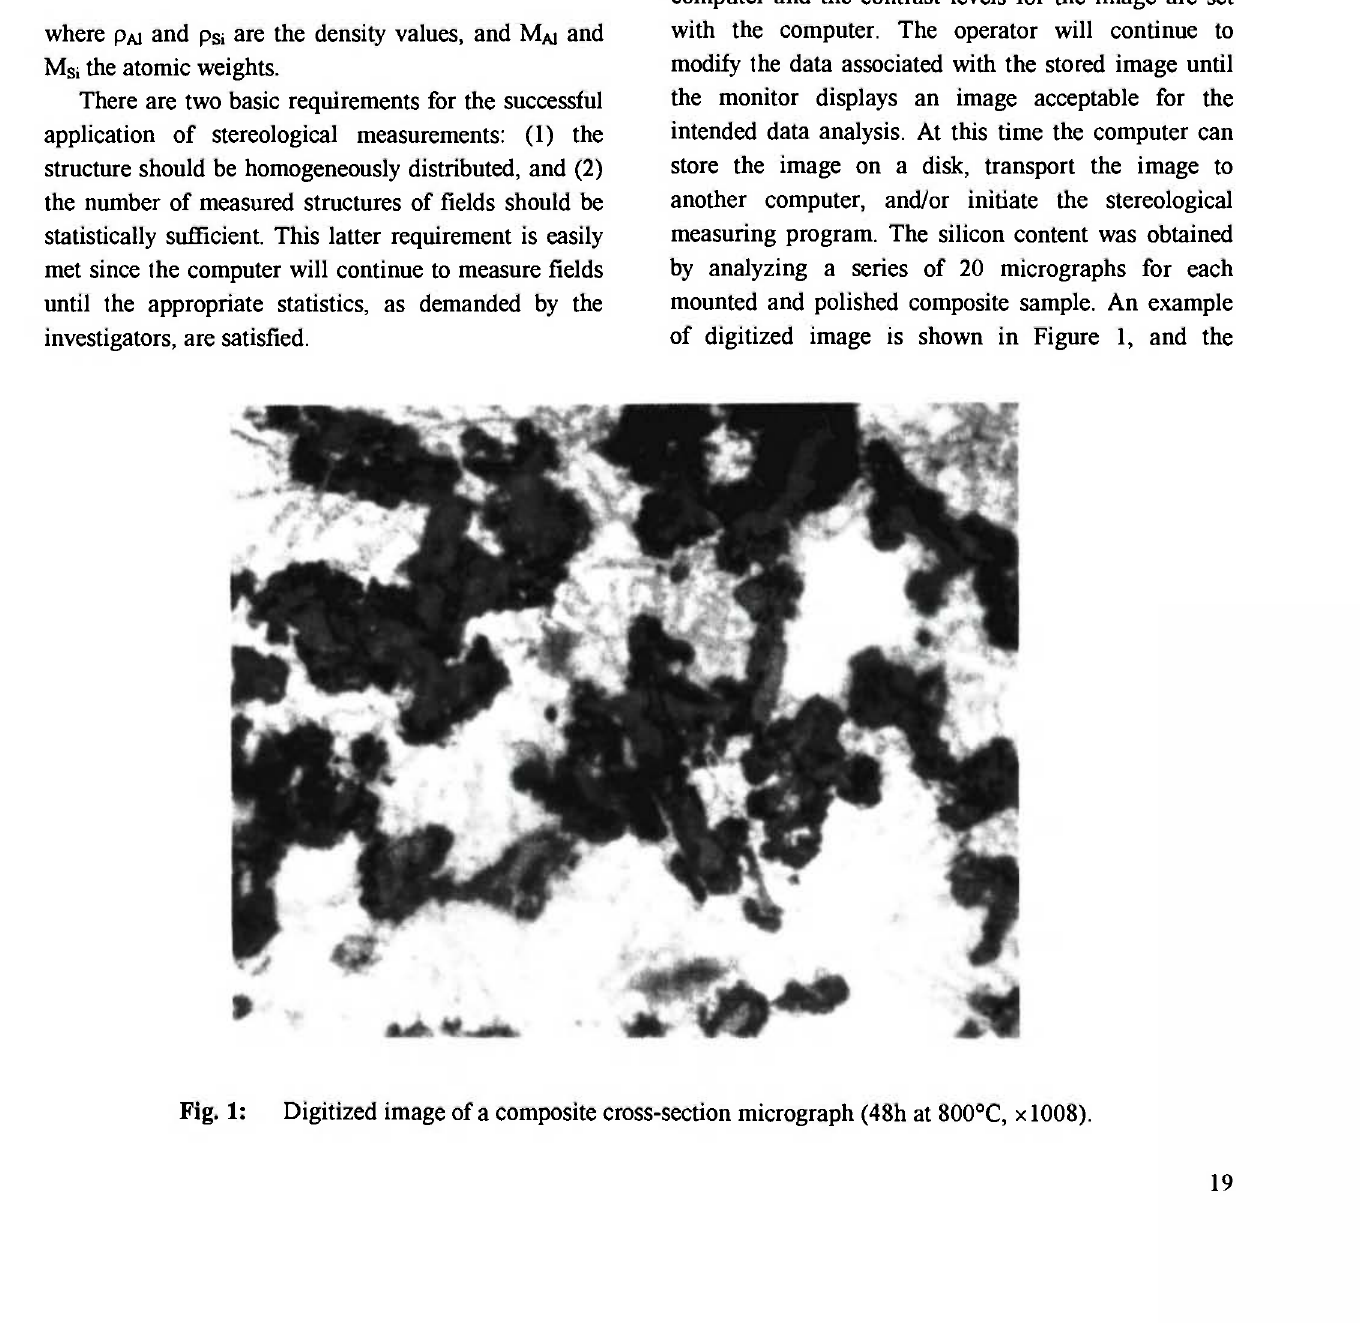
Fig. 1: Digitized image of a composite cross-section micrograph (48h at 800°C, χ